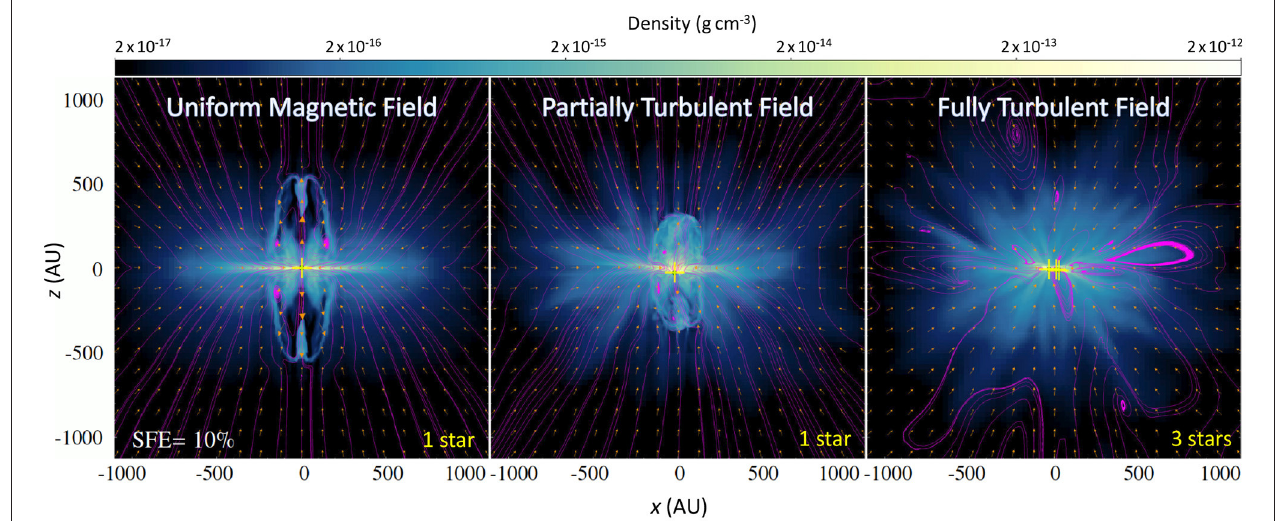
FIGURE 8 | Protostellar disc and jet formation simulations with different magnetic field geometries. The (left) panel shows the standard approach of using an initially uniform magnetic field aligned with the rotation axis of the core and disc. The (middle) panel adds a turbulent component to the uniform field component, such that both have the same rms. The (right) panel show the same simulation, but with a completely turbulent magnetic field (no guide-field component present). Outflows are strongest in the uniform-field case, with a fast collimated jet component launched from the inner parts of the disk. Partially turbulent magnetic fields still generate an outflow, but weaker and less collimated. In the absence of a uniform field component, however, jets are completely suppressed, but fragmentation of the disk is induced, i.e., three stars form in the fully turbulent case, compared to only a single star in the other two simulations. Figure adopted from Gerrard et al. (under